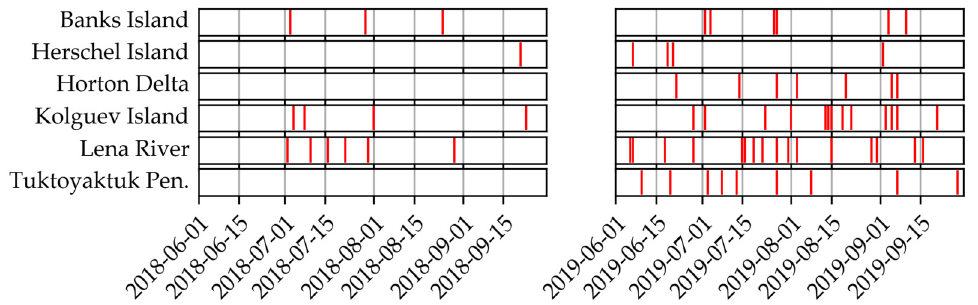
Figure 2. Temporal distribution of input data by study region.